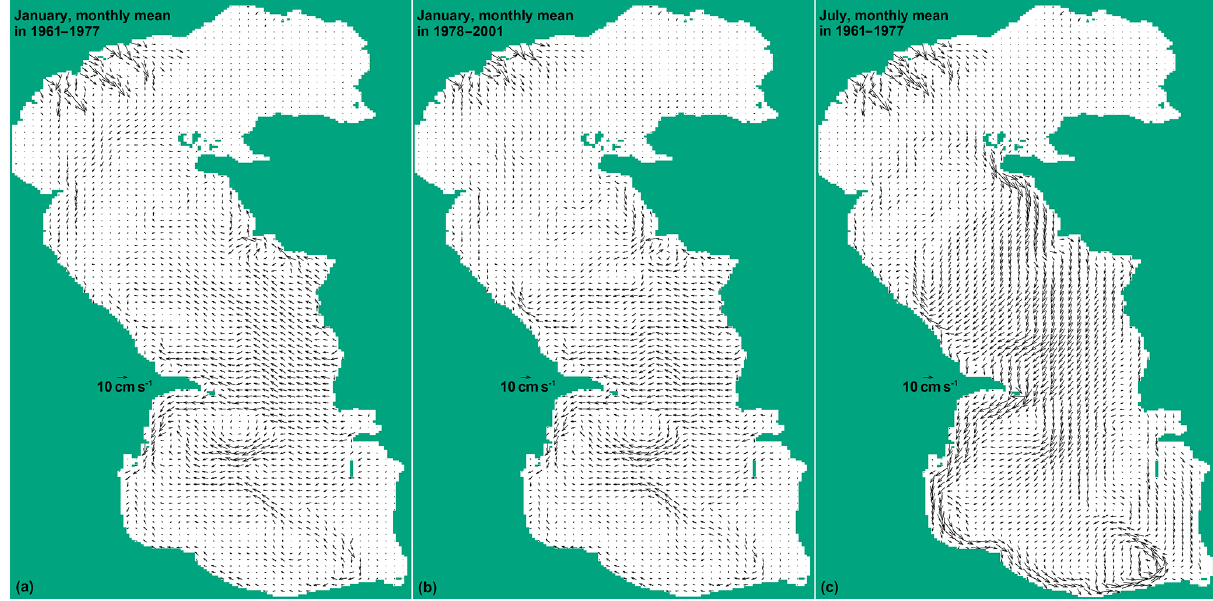
Figure 3. Model monthly mean surface currents in January (a, b) and July (c) averaged over 1961–1977 (a, c) and 1978–2001 (b) .